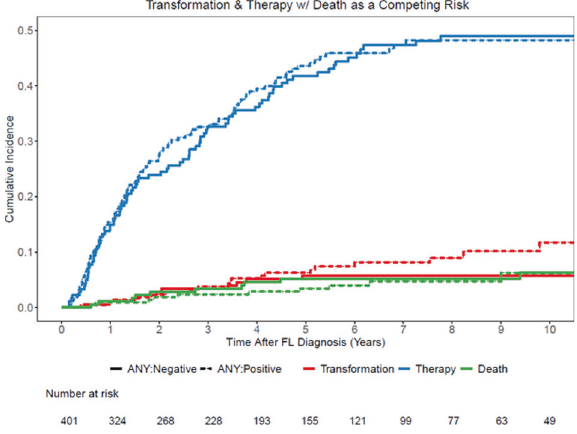
Fig. 2 Estimates of treatment initiation, transformation and death based on treatment initiation criteria. Cumulative incidence estimates of treatment initiation, transformation and death based on presence or absence of any treatment initiation criteria.